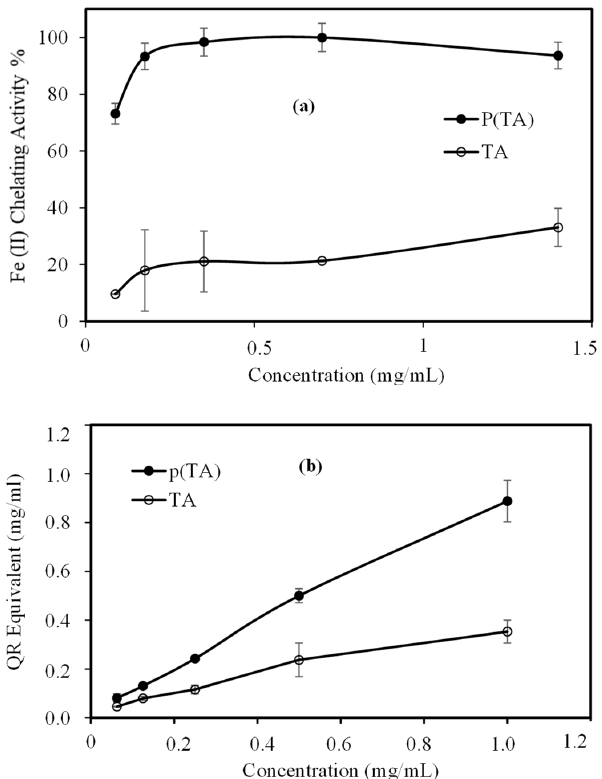
Figure 6. ( a ) Fe(II) chelating% of TA and p (TA) particles, and ( b ) total flavonoid content (TFC) of TA and p (TA) in comparison to quercetin (QR) equivalent.